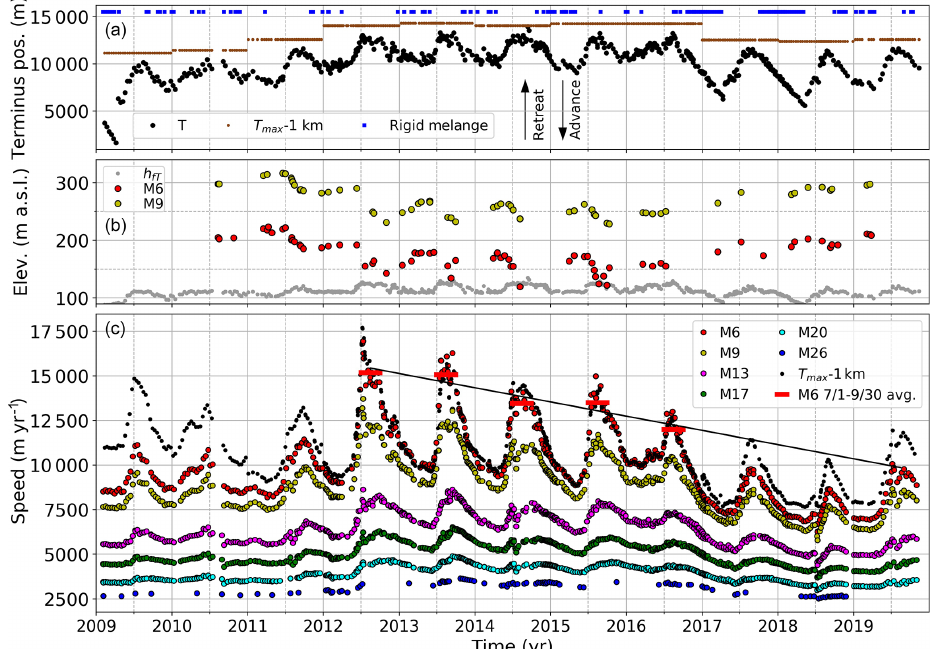
Figure 2. (a) Terminus position ( T : black circles) and position 1km upstream of annual minimum terminus extent ( T max − 1km: brown dots). Terminus positions are given as distances measured relative to the seaward origin of our reference profile (see Fig. 1), and the arrows show the direction of retreat and advance. Two points in 2014 were excluded in determining T max − 1km (see text). The blue squares indicate when rigid mélange was present in front of the terminus at the locations indicated by the blue boxes in Fig. 1. (b) Elevations of the points M6 (red) and M9 (gold) extracted from all available DEMs along with the inferred flotation height, h fT (grey), at the terminus. (c) Surface speeds through time extracted from a TerraSAR-X/TanDEM-X velocity time series, with a few points from summer 2019 derived using COSMO-SkyMed data. See Fig. 1 for the locations of points M6–M26. The black circles indicate the speed at T max − 1km. Because this minimum position is updated annually, unlike the static points, there are discontinuities at each year boundary since the sampling point location changes (e.g. brown points in the top plot). The average summer (1 June to 30 September) speeds are shown as red bars for the five summers when the terminus was most retreated (2012–2016). A linear fit ( r 2 = 0 . 91, p = 0 . 013) to these summer averages is shown with a black line that extrapolates the trend through